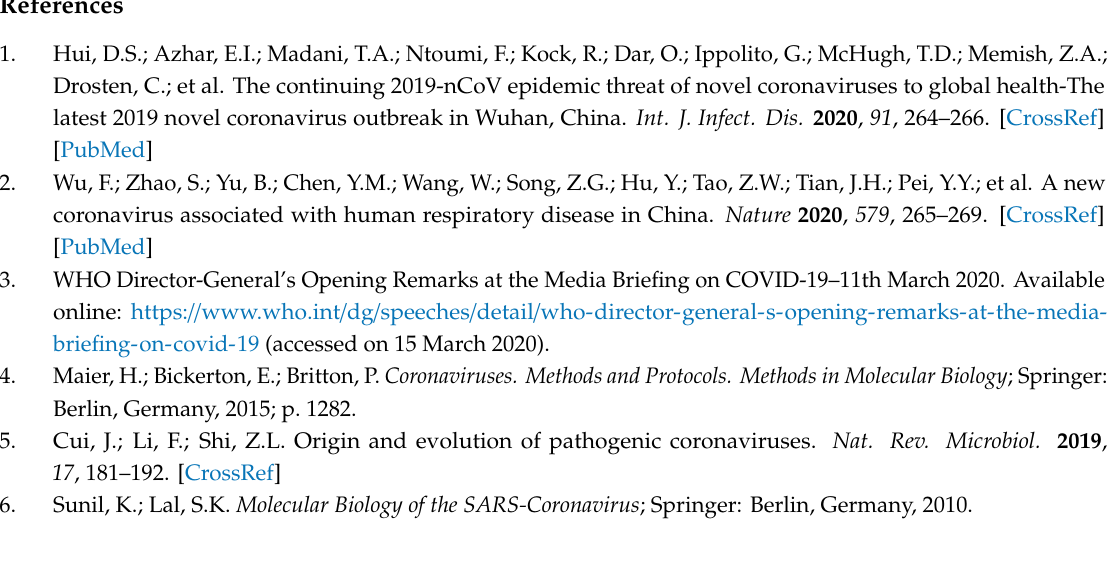
Supplementary Materials: The following are available online, Table S1: PDB structures (as of July 1, 2020) complexed with Ligands of Interest (LOI), as reported in the COVID-19 / SARS-CoV-2 Resources page of the Protein Data Bank. Columns refer to the PDB code, release date, target name(s) and LOIs (ID, Molecular Weight, and InCHIKey), Table S2: List of compounds subjected to virtual screening, and Table S3: Chemical-physical characteristics of the compounds present in the library, calculated using the DataWarrior software v5.2.1 [60]. Values in the Drug-like column are 1 if and only if the number of violations of Lipinski’s Rule of Five [61] are < 2, otherwise zero. Likewise, values in the Lead-like column are 1 if and only if the number of violations of Oprea’s lead-like test [62] are < 2, otherwise